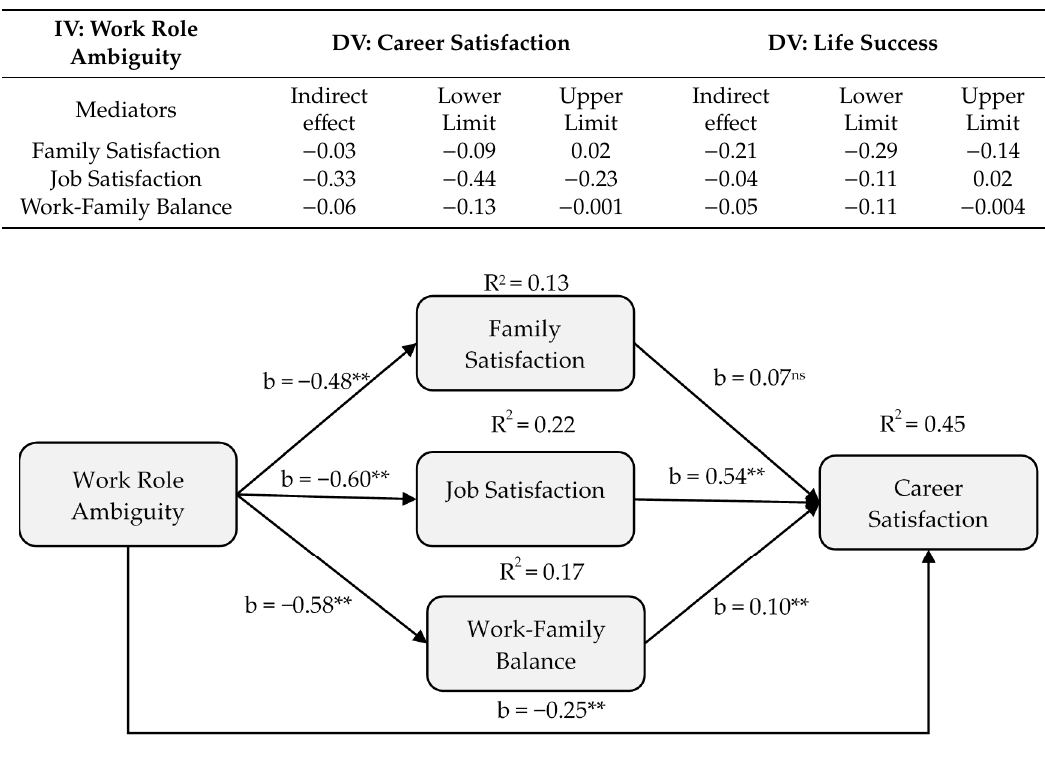
Figure 4. Mediational model of work role ambiguity and career satisfaction.